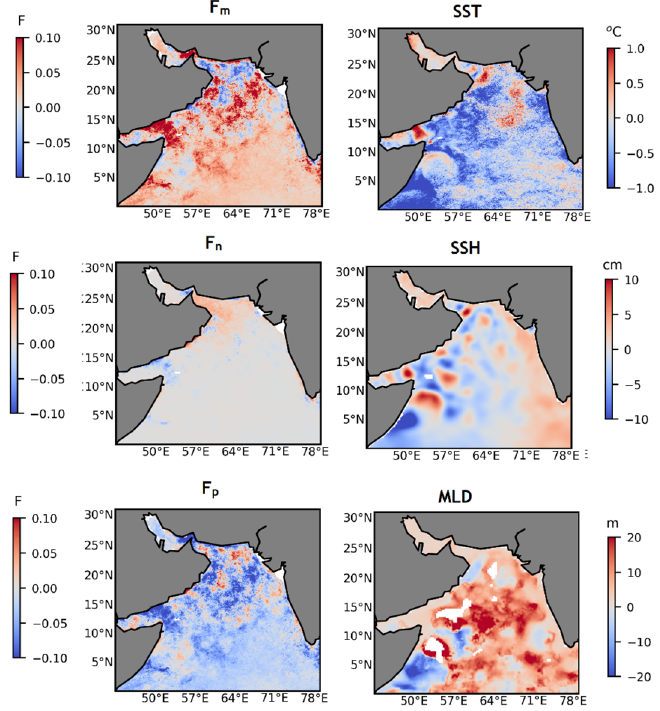
Figure 9. Monthly anomaly map of F m , F n , F p , SST, SSH and MLD during the extreme negative IOD (July 2016) in the Arabian Sea.